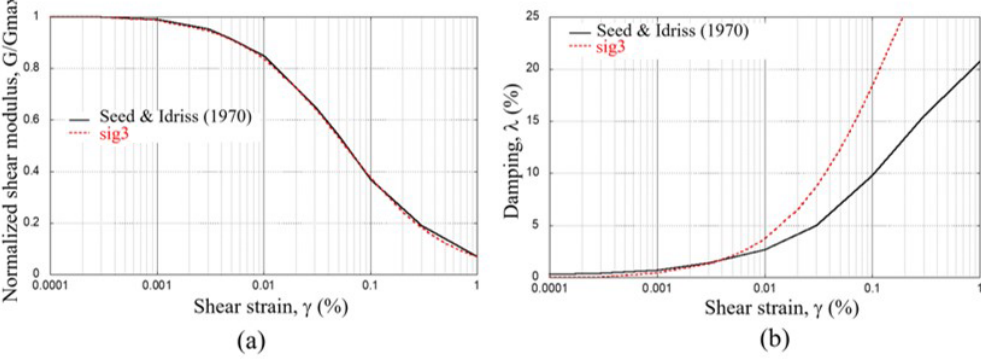
Figure 17. Results obtained from Seed and Idriss (1970) and the sig3 model.